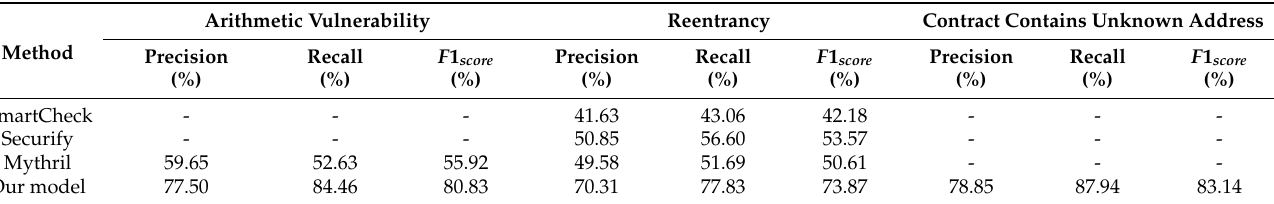
Table 8. Experimental results of the baseline model.